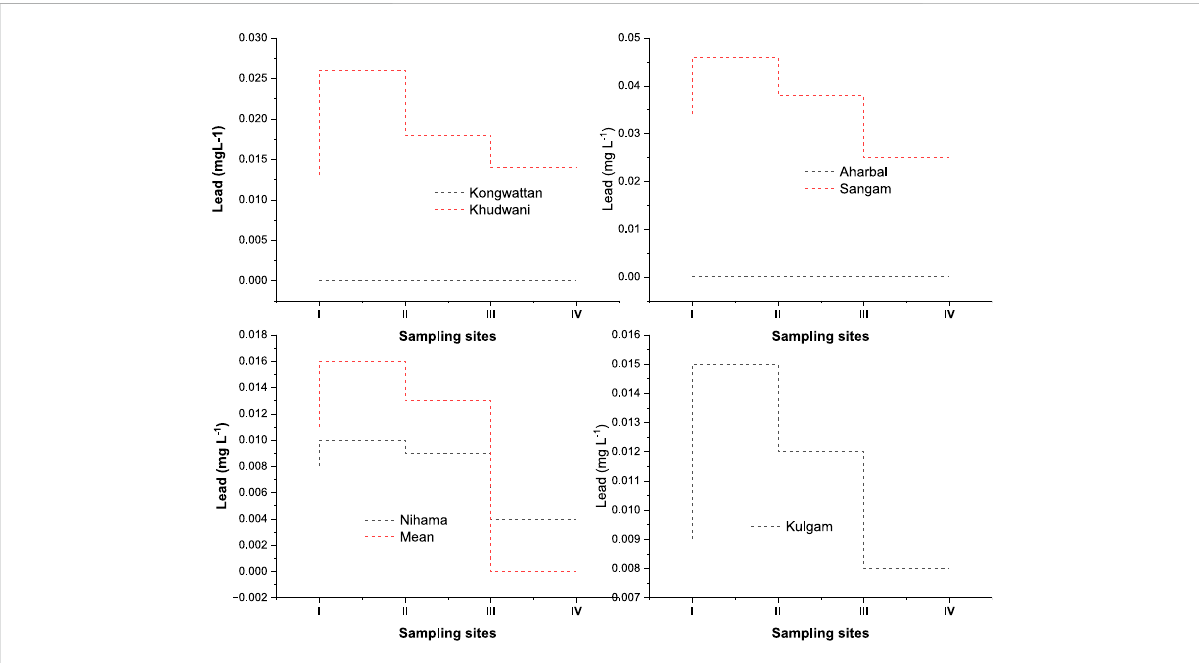
FIGURE 4 Figure depicting the comparative time-series seasonal variation analysis of Lead (Pb) in the water of the River Veshaw at six different sites collected during all the seasons from spring to winter (I:spring; II:summer; III:autumn; IV:winter; V) Each symbol represents the mean of triplicate